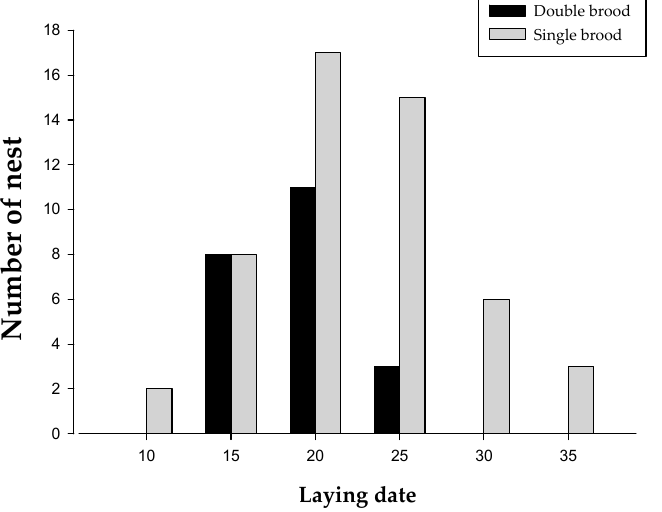
Figure 1. Frequency distribution of laying date (1 = 1 Apr) of the first broods ( n = 22) and single broods ( n = 51) in the great tits.